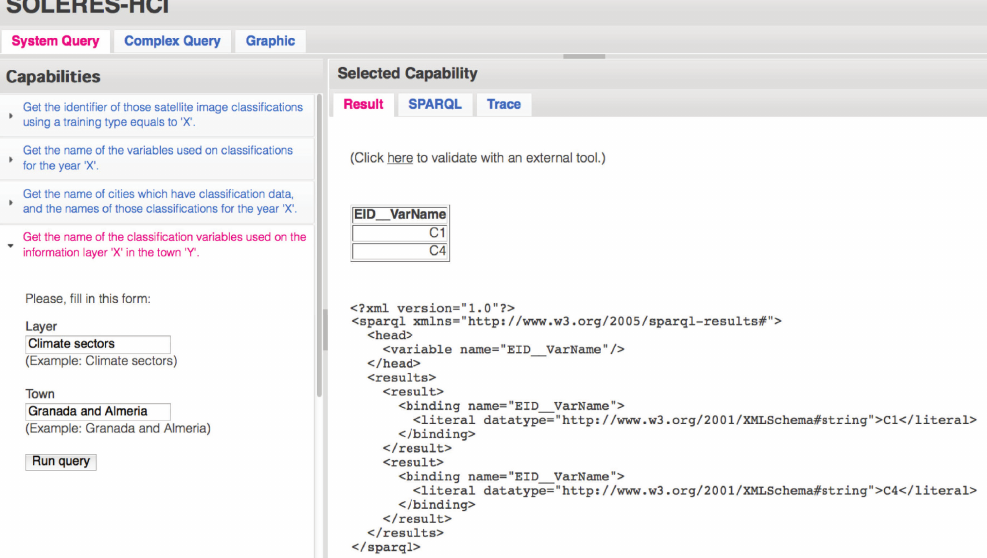
Figure 14: A part of the System Query window in the test environment.